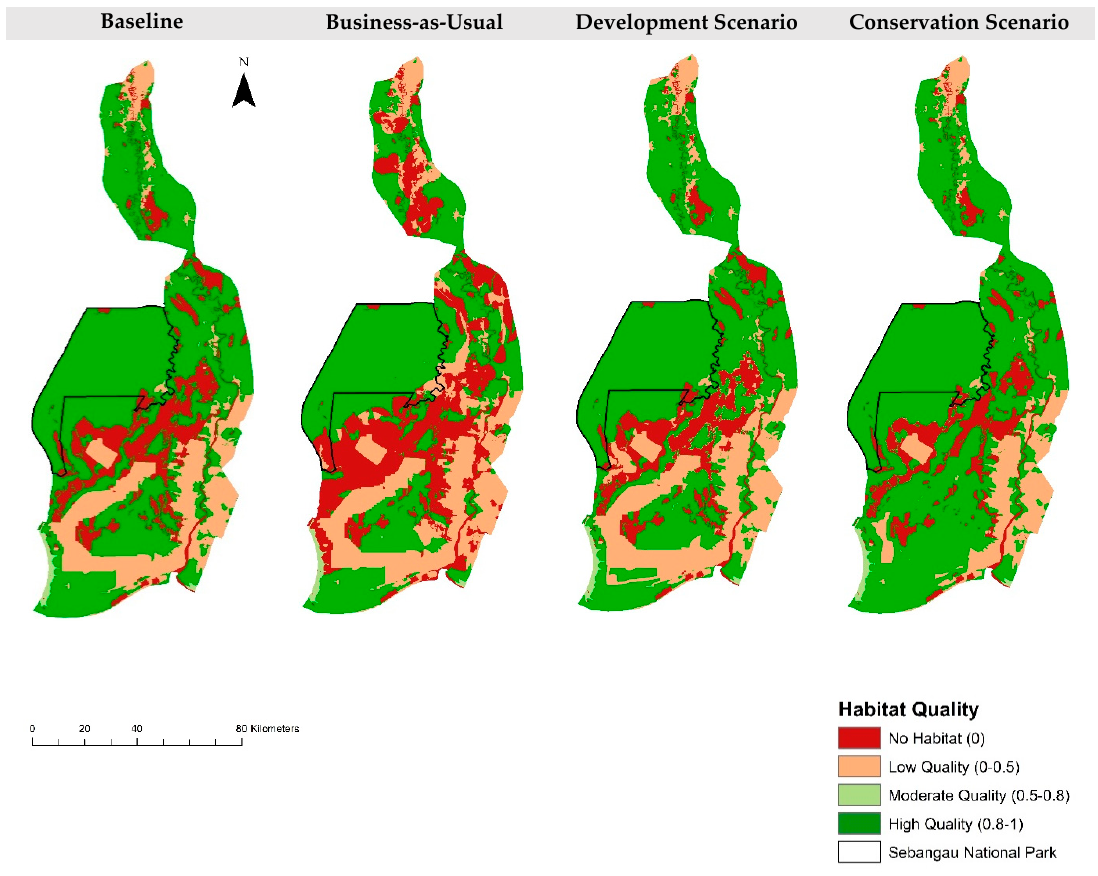
Figure 4. Spatial distribution of habitat quality in Baseline, BAU, DS, and CS. Table 2. Landscape habitat quality score (Low 0—High 1) and habitat quality percentage change from baseline (in brackets).